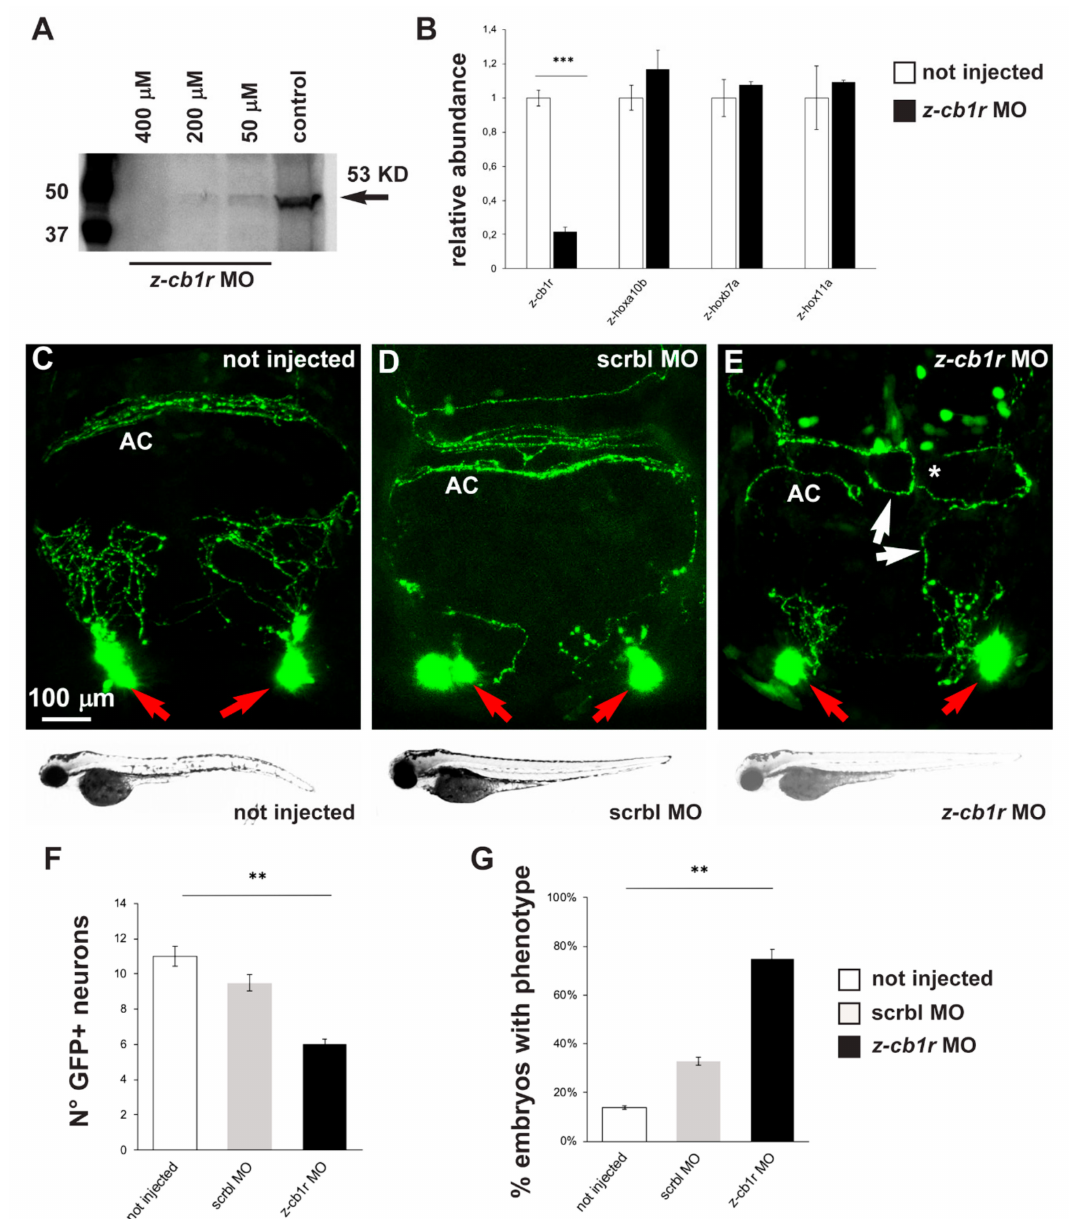
Figure 3. E ff ects of MO-mediated CB1R knockdown on GnRH3 neurons in zebrafish embryos. ( A ) Western blot analyses of protein extracts from uninjected or z-cb1r MO-injected zebrafish embryos. A significant depletion of the CB1R protein was detected in the treated embryos. ( B ) Real-time qPCR analyses of z-cb1r and three z-hox genes on RNA samples extracted from uninjected (open bars) or z-cb1r MO-injected (solid black bars) embryos. Expression is shown relative to the expression of the housekeeping gene mRNA ( z- β -actin ). The abundance of the control RNA is set as 1. A depletion of the z-cb1r mRNA in embryos injected with z-cb1r MO is observed, as compared to control ones. No change in the expression of z-hox genes was observed, indicating unaltered developmental progression. ( C – E ) Representative images of EGFP GnRH3 neurons and projections in the nasal and the basal forebrain regions of zebrafish embryos, at the age 72 hpf. The observation plane is the same as in Figure 2. Scale bar is reported in C . Red arrows indicate EGFP + neurons, white arrows indicate altered EGFP + projections, and white asterisks indicate altered organization and fasciculation at the anterior commissure. Below each micrograph, the bright-field images show the general morphology and growth of the corresponding whole animal, with no di ff erence between the three conditions. ( F )